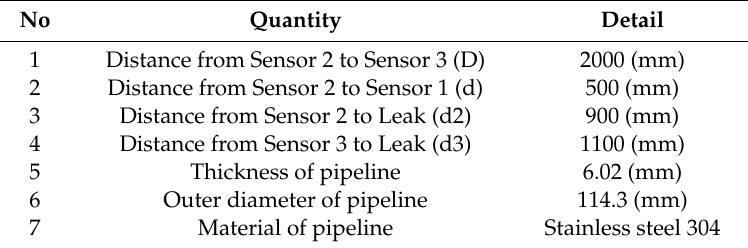
Table 1. Experimental